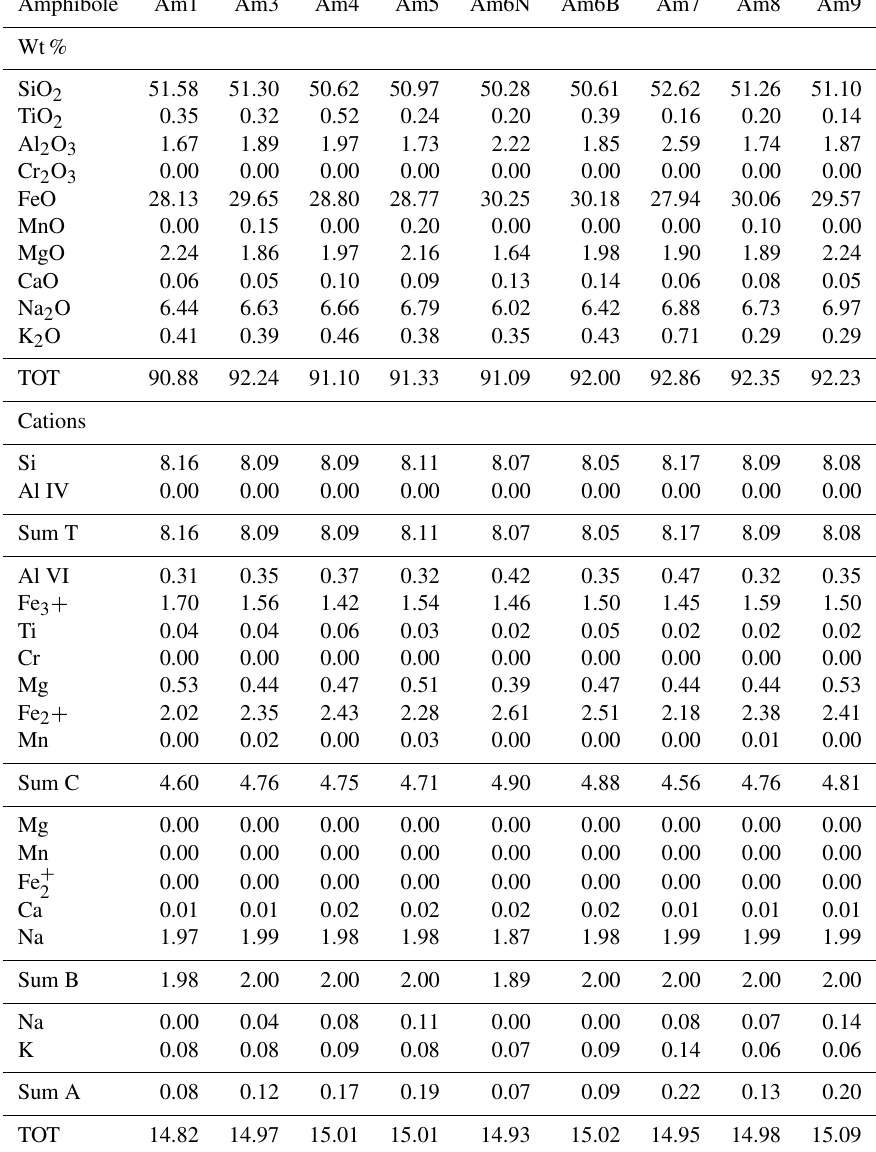
Table 1. Representative microprobe analyses (wt%) of coesisting minerals within the metamorphic assemblage. Na-amphiboles structural formulae were calculated assuming 23 oxygens per anhydrous formula